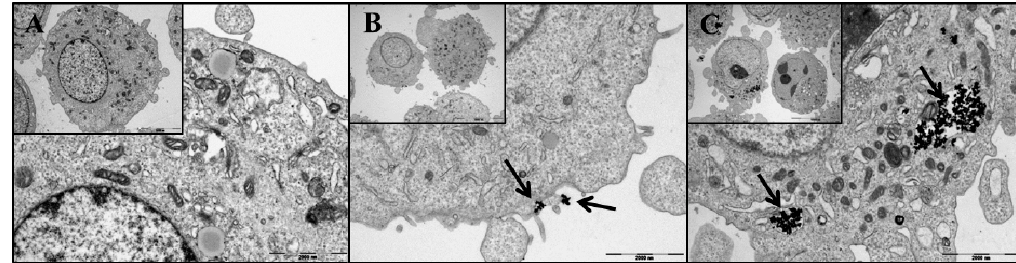
Figure 4. TEM images of PC-3 cells. ( A ) Cells only; ( B ) Cells with 60-nm CoFe 2 O 4 -HP; ( C ) Cells with 60-nm CoFe 2 O 4 -HP-FA. Cells were incubated with 6.25 μ g/mL CoFe 2 O 4 -HP or CoFe 2 O 4 -HP-FA for 2 h in the dark. Scale bar: 2 μ m.